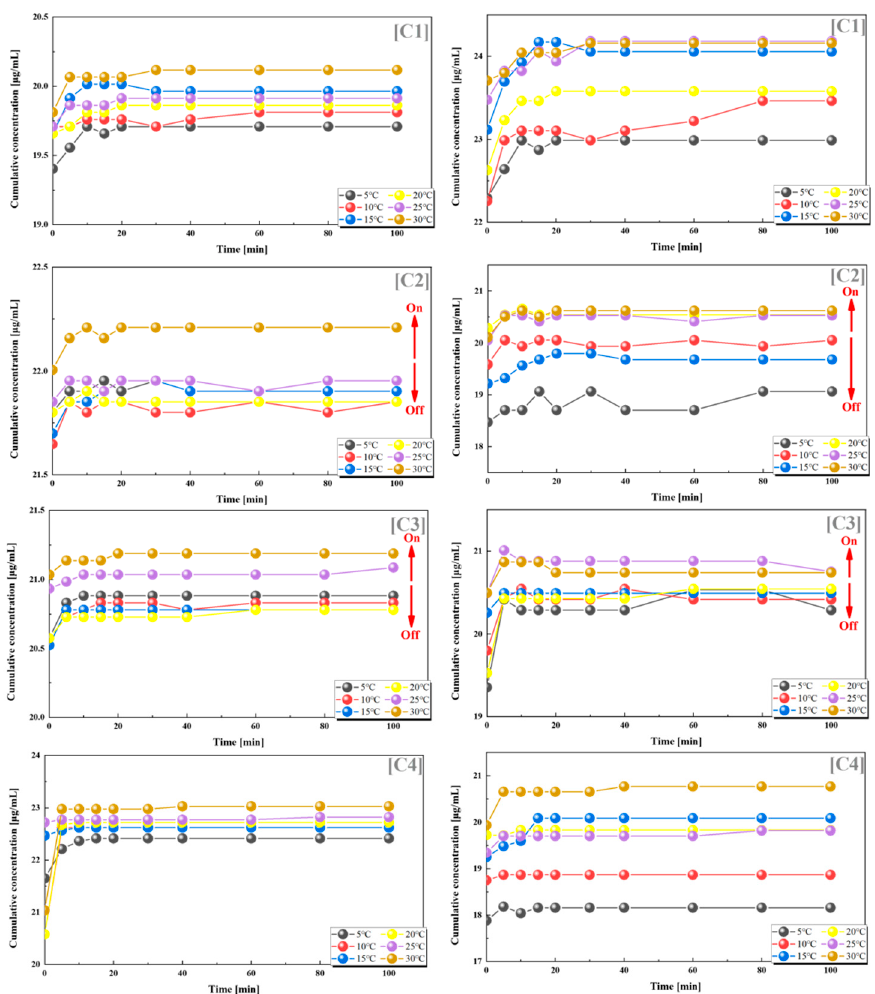
Figure 5. Release of VB12 (left) and vancomycin hydrochloride (right) from systems with different combinations of grafting rates at different temperatures. ( C1 ) 17–10%; ( C2 ) 17–15%; ( C3 ) 17–20%; ( C4 ) 17–24%. All the above combinations are for PES-g-PAAM microcapsules and PES-g-PAAC microcapsules with different grafting rates.